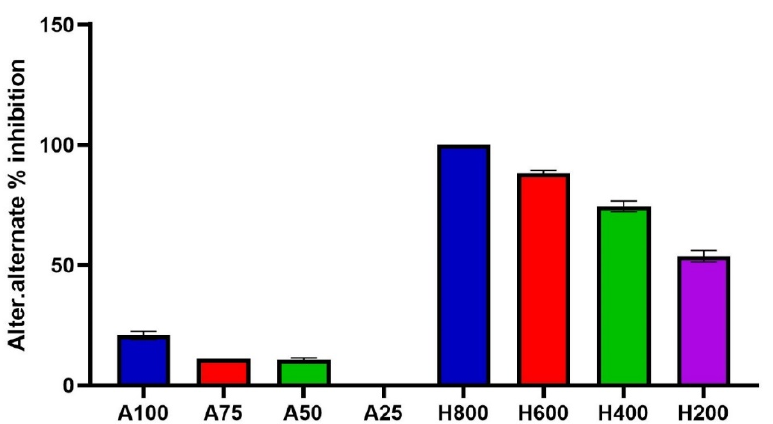
Figure 5. Mycelial growth % inhibition of Citrus lemon essential oil and its nano-hemosome formula .